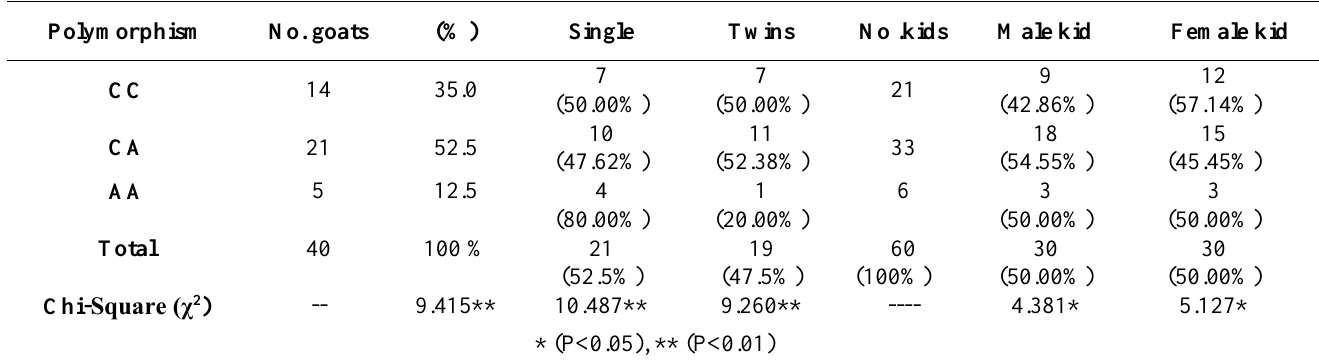
Table 3. Allele frequency of MTNR1A gene in local goats